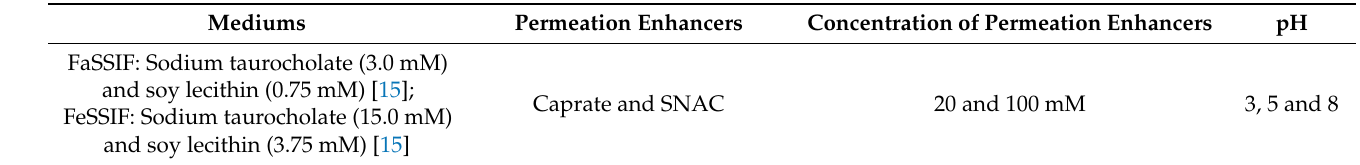
Table 1. Simulations performed with different combinations of biorelevant media and their composi- tion, permeation enhancers and pH of the systems. Mediums Permeation Enhancers Concentration of Permeation Enhancers pH FaSSIF: Sodium taurocholate (3.0